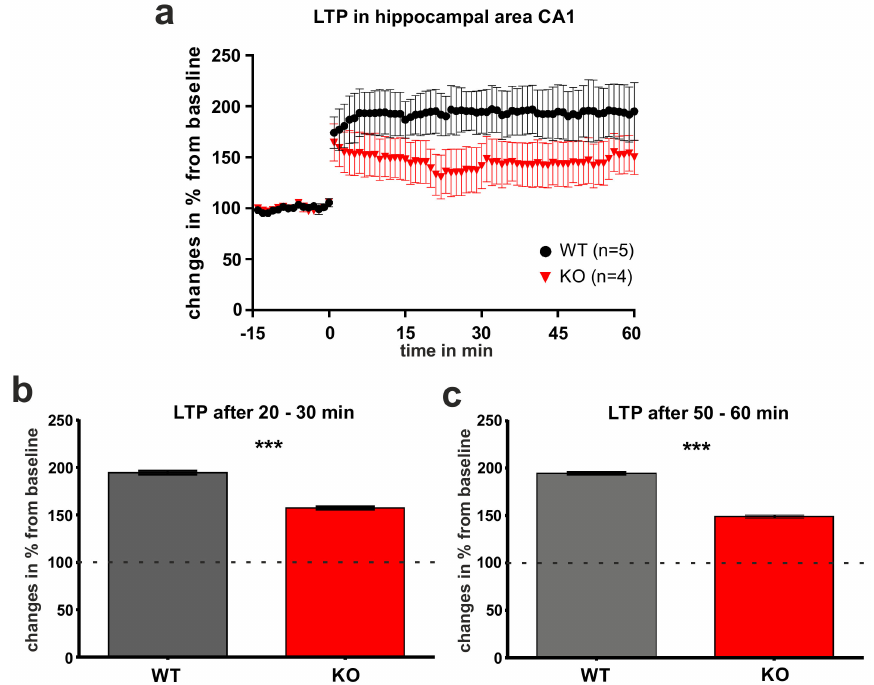
Figure 4. LTP within hippocampal area CA1. ( a ) LTP could be induced in both controls and FTSJ1- deficient mice, and stable LTP could be recorded over a long period. ( b ) About half an hour after LTP induction, LTP in FTSJ1-deficient mice (KO) was weaker as compared to controls (WT) and differed significantly from controls (20–30 min after LTP induction). ( c ) About one hour after LTP induction, the FTSJ1-deficient mice (KO) still displayed a stable LTP as compared to controls (WT), but it remained at a lower level. Dotted line indicates baseline level set to 100%. Data are shown as mean ± SEM; baseline was set to 100%. *** indicates significant differences ( p <